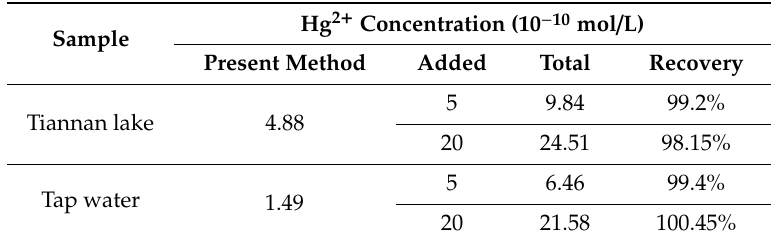
Table 1. The RFN for the detection of Hg 2 + in Tiannan lake water and tap